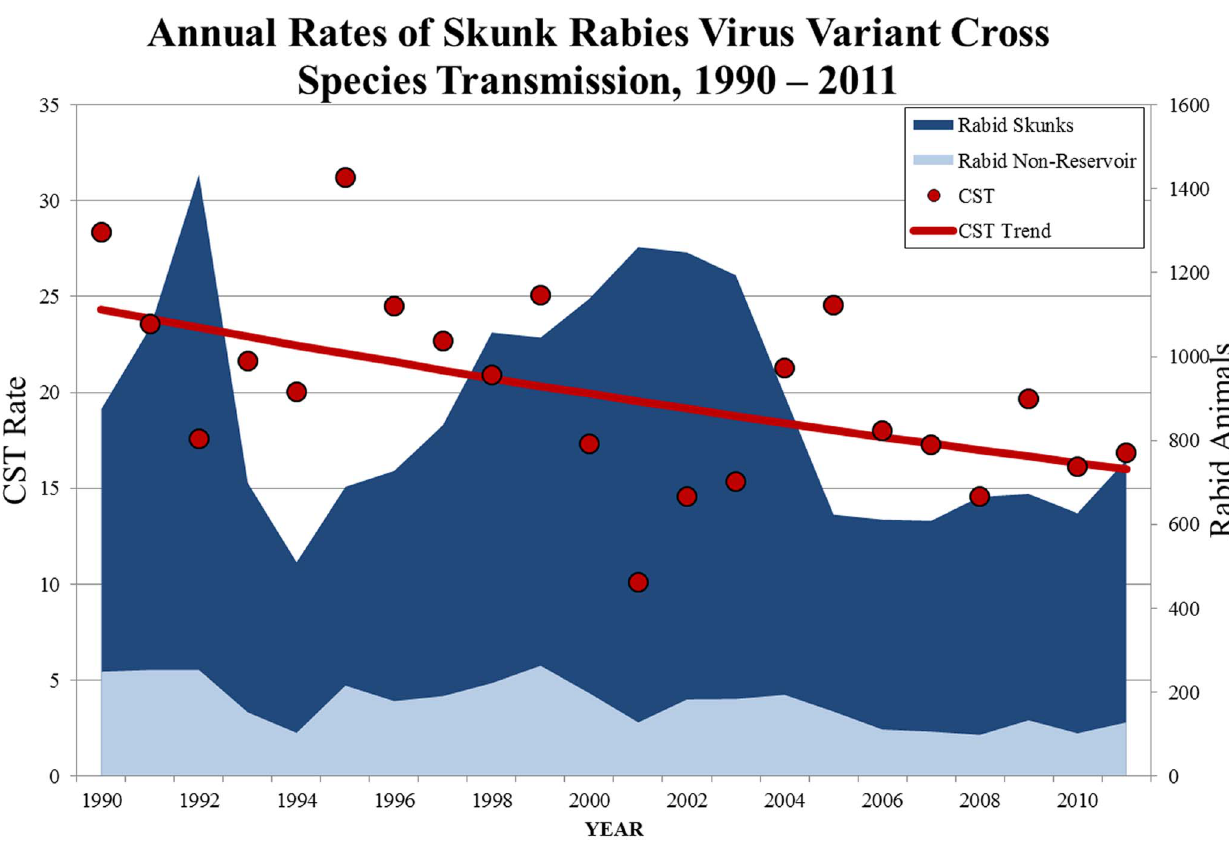
Figure 2. Annual Rates of Skunk Rabies Virus Variant Cross Species Transmission, 1990–2011.